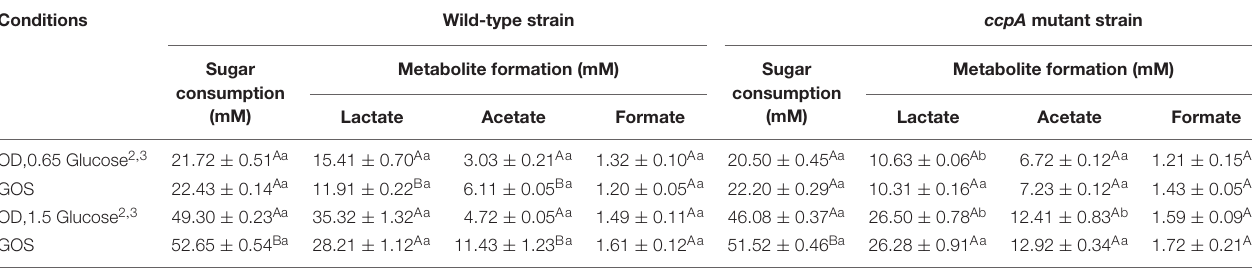
TABLE 1 | Comparison of sugar consumption and metabolites resulting from the fermentation of GOS or glucose by wild-type L. plantarum ST-III or L. plantarum (cid:49) ccpA at OD 600 of 0.65 and OD 600 of 1.5 1